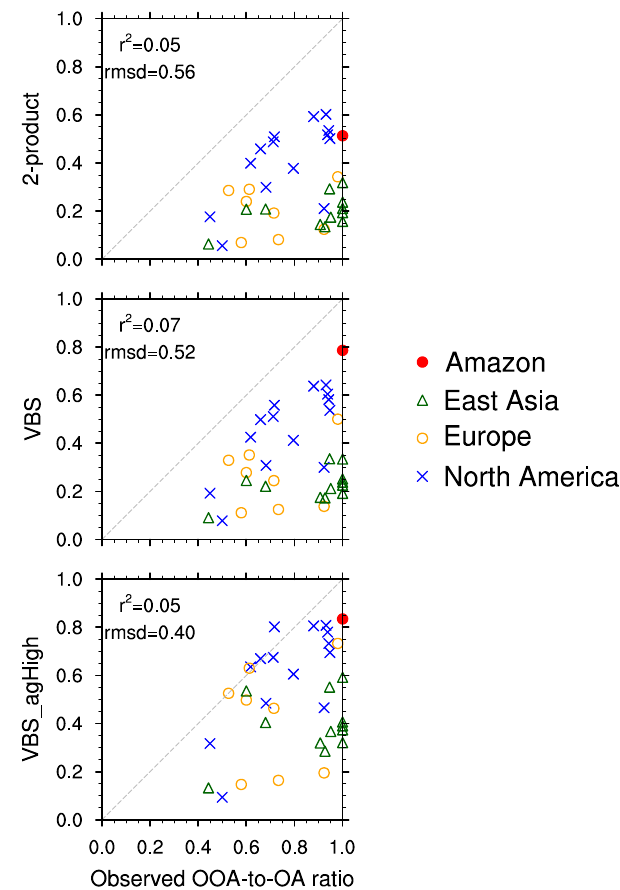
Figure 7. Comparison of observed OOA-to-OA ratio from surface AMS measurements and simulated SOA- to-OA ratio from the 2- product, VBS and VBS_agHigh schemes. r 2 and rmsd are included in each